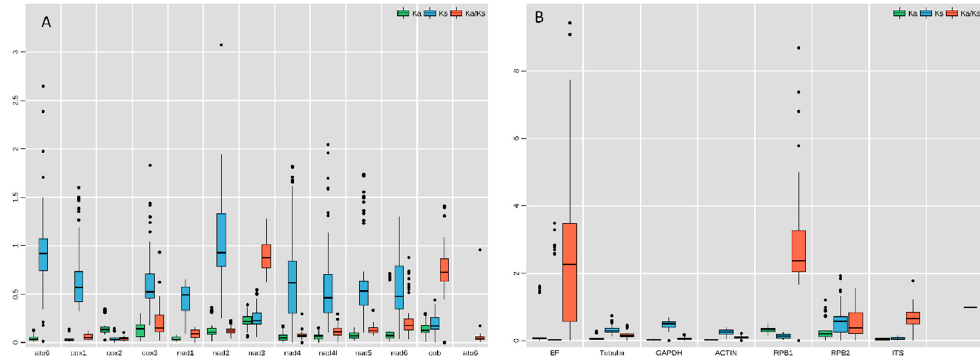
Figure 5. Figure 5. Evolutionary rates of the mitochondrial genes ( A ) and nuclear genes ( B ). The Ka (non- synonymous) and Ks (synonymous) values, as well as their Ka/Ks ratio appear as green, blue and red box plots, respectively. The bar represents standard deviation (SD), median and epitomizes values between the first quartile and the third quartile of Ka, Ks and Ka/Ks.